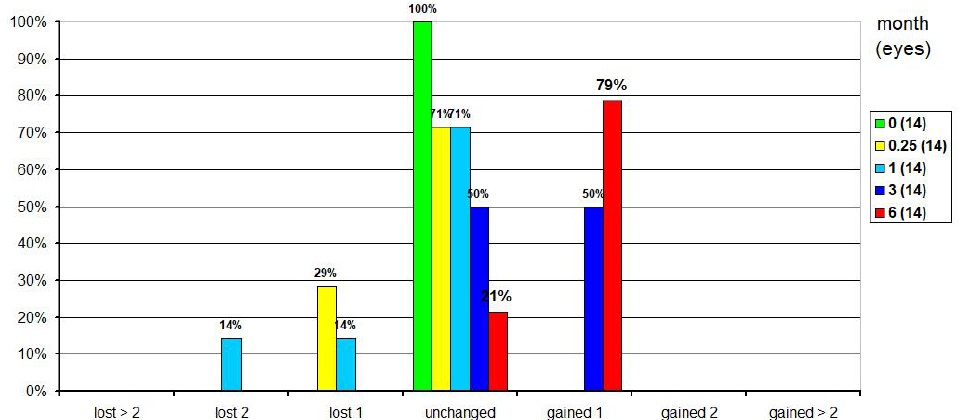
Figure 5. Safety: Changes in corrected distance visual acuity over time compared to preoperative values.